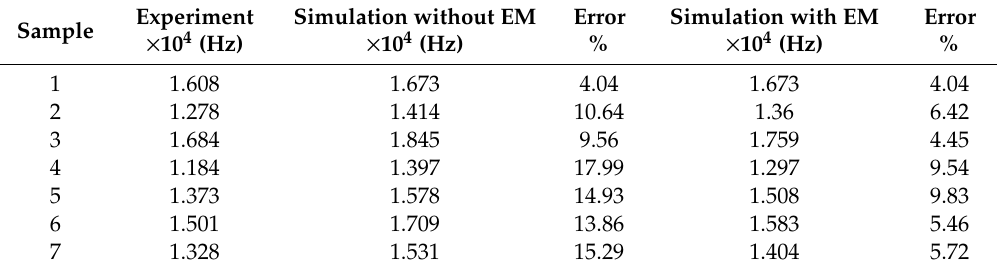
Table 6. Comparisons of resonant frequency between simulations and modal